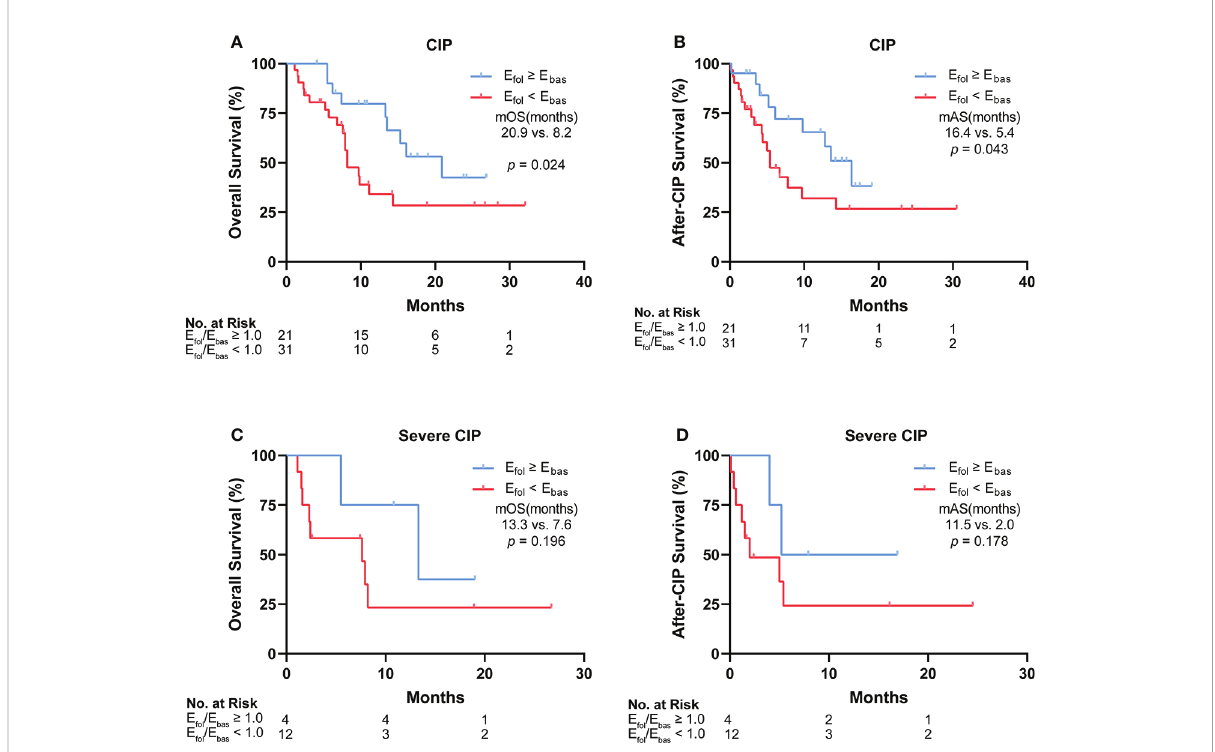
FIGURE 5 Correlation between E fol / E bas value and the long-term survival of patients with CIP and severe CIP. (A) Kaplan – Meier analysis of OS in patients strati fi ed according to E fol / E bas value for CIP. (B) Kaplan – Meier analysis of after-CIP survival in patients strati fi ed according to E fol / E bas value for CIP. (C) Kaplan – Meier analysis of OS in patients strati fi ed according to E fol / E bas value for severe CIP. (D) Kaplan – Meier analysis of after-CIP survival in patients strati fi ed according to E fol / E bas value for severe CIP. The statistical analysis was conducted by the Gehan – Breslow – Wilcoxon test. E fol / E bas , eosinophil percentage fold change from the baseline to the follow-up point; CIP, checkpoint inhibitor pneumonitis; OS, overall survival; mOS, median overall survival; mAS, median after-CIP